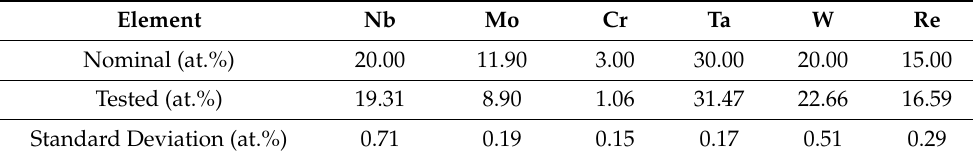
Figure 8. ( a ) SEM image of sample surface after polishing; ( b ) energy dispersive spectroscopy (EDS) testing areas on the sample surface. Table 3. EDS testing results of the polished sample surface.